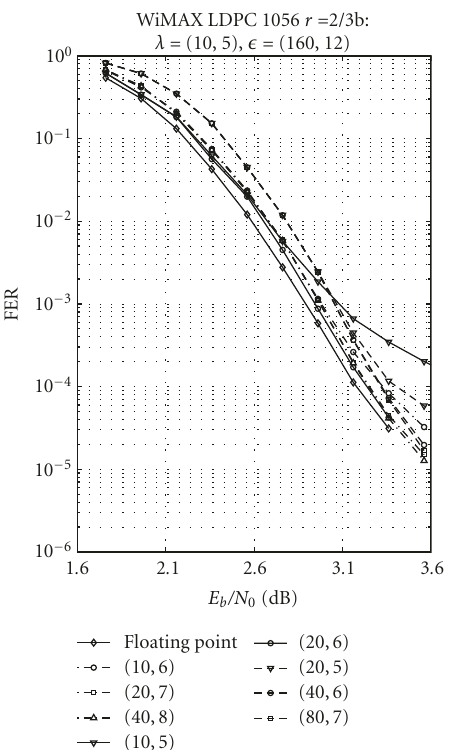
Figure 17: WiMAX LDPC code: e ff ects of the quantization of check to variable, soft-output, and variable to check